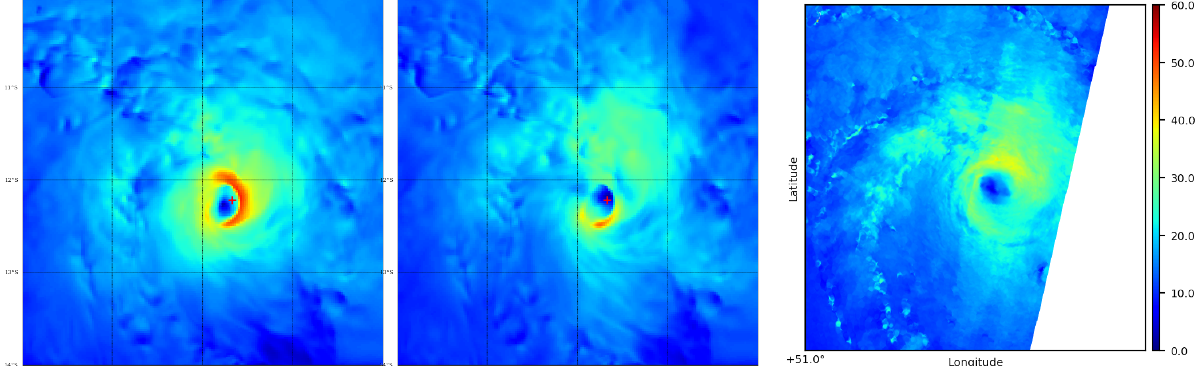
Figure 10. Background ( left ) and analysis ( middle ) of 7 February 2019 02:00Z for SAR_12km_2ms and SAR wind speed observations ( right ) at 02:09Z in area (51° E–55° E, 10° S–14° S). Units are m · s − 1 . Red cross is the estimated TC center position interpolated from TC position extracted from BT on 7 February 2019 00:00Z and